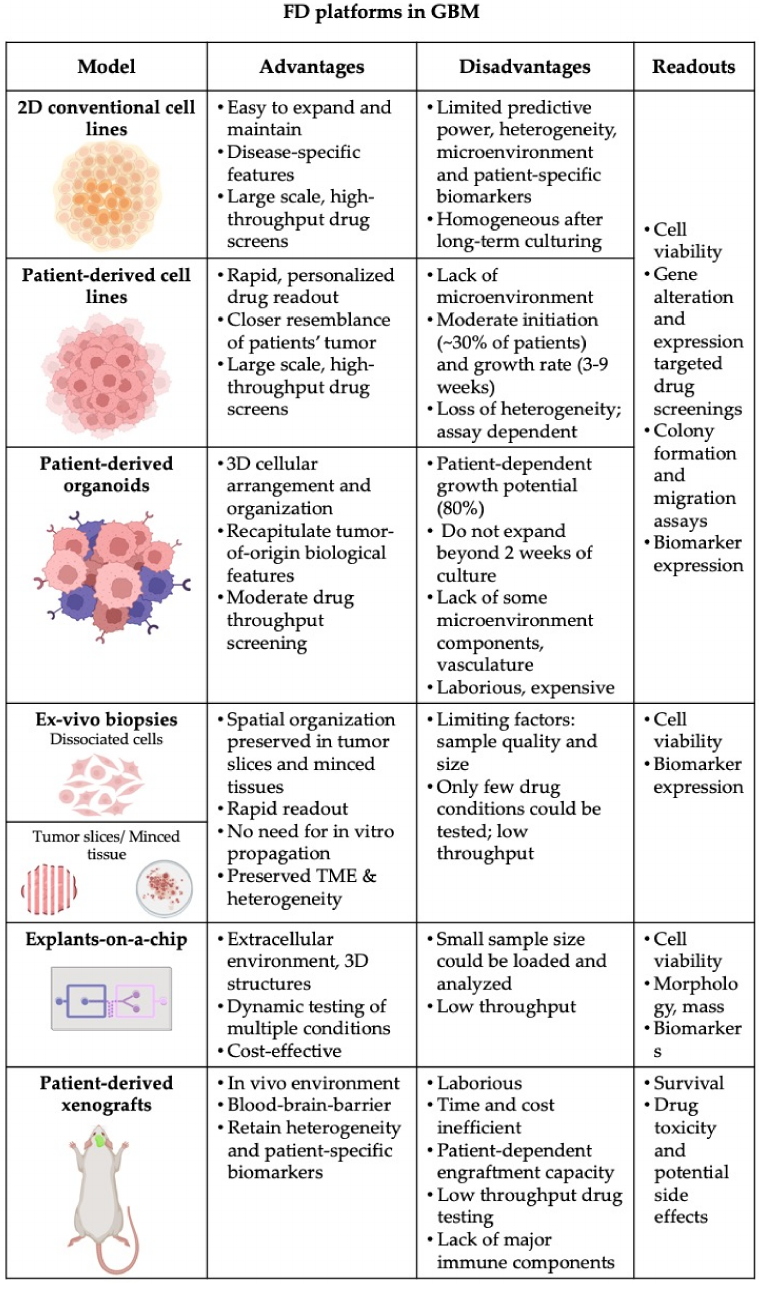
Figure 2. Summary of pre-clinical models and platforms, which could be used for functional testing in GBM. Advantages and disadvantages of each model together with potential assay readout are outlined (Created with